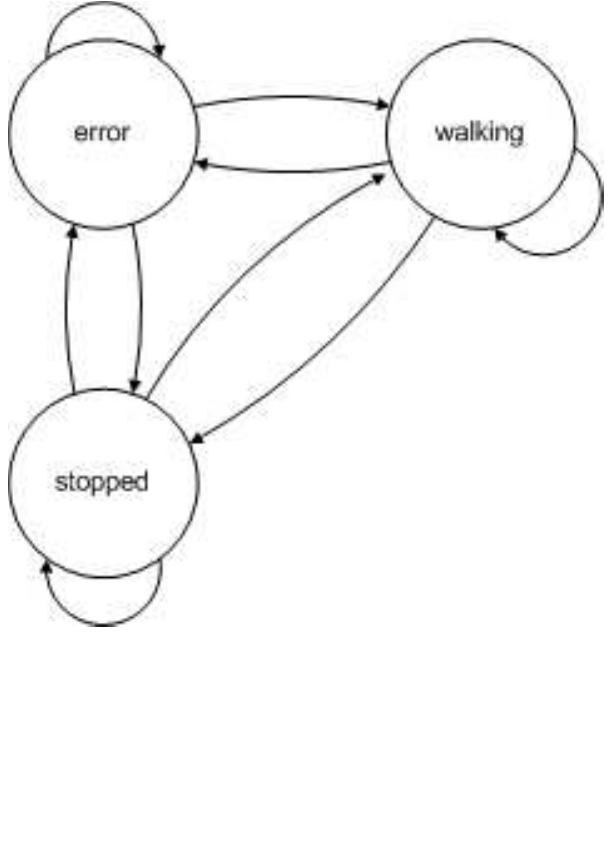
Figure 6. Structure of the HMM used in experiment 1